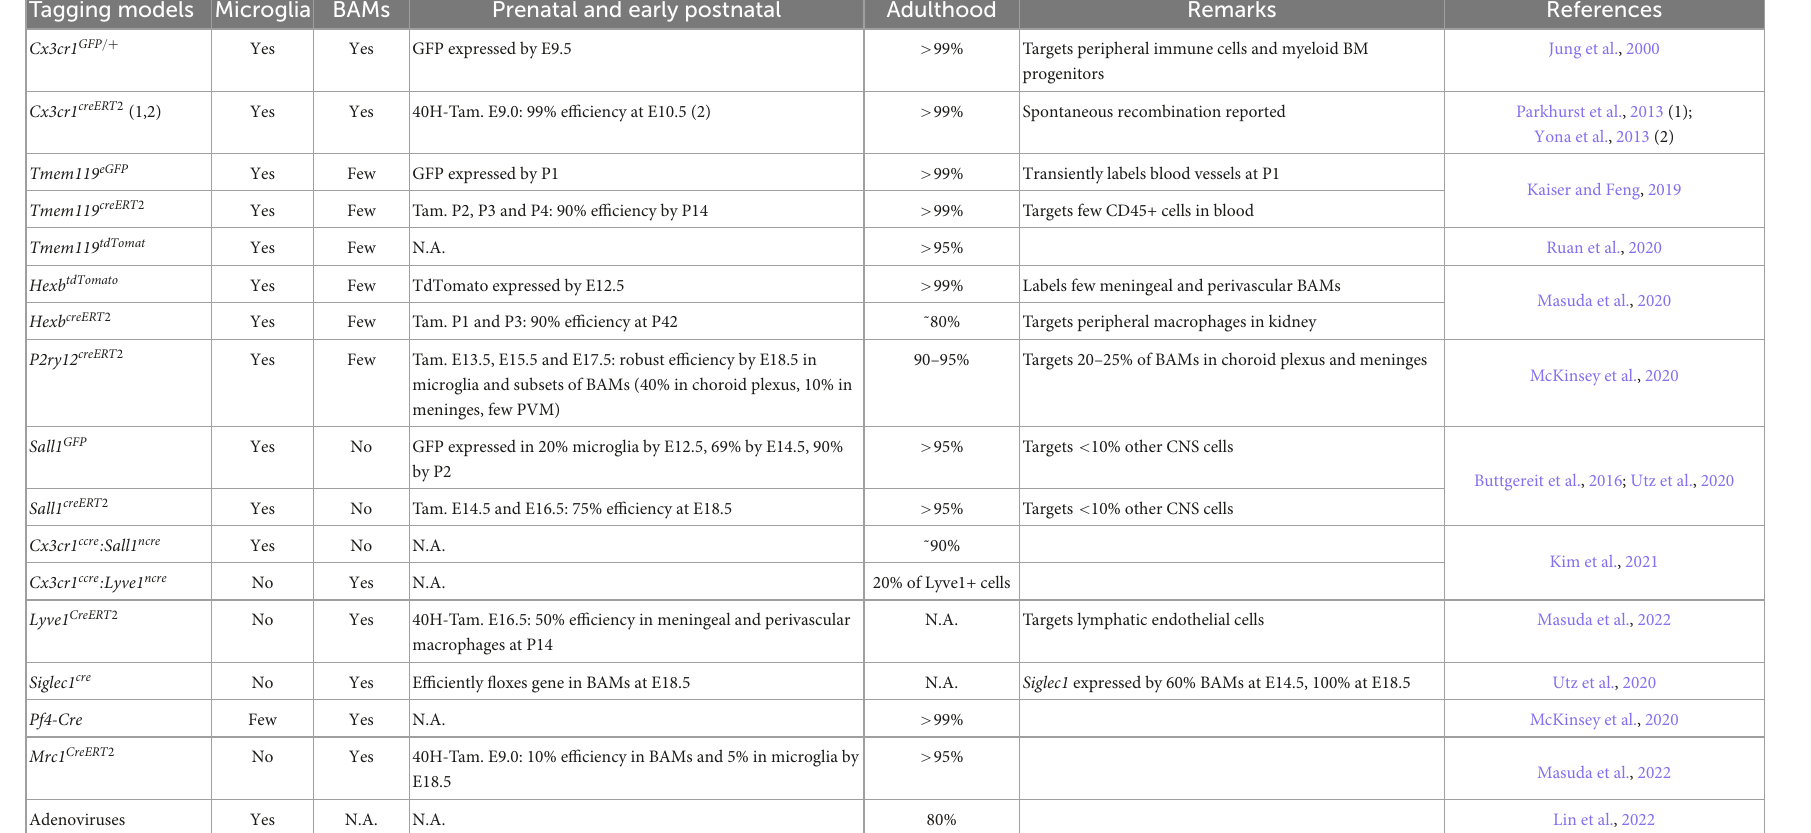
TABLE 1 Tools to label, target and deplete microglia and BAMs. Tagging models Microglia BAMs Prenatal and early